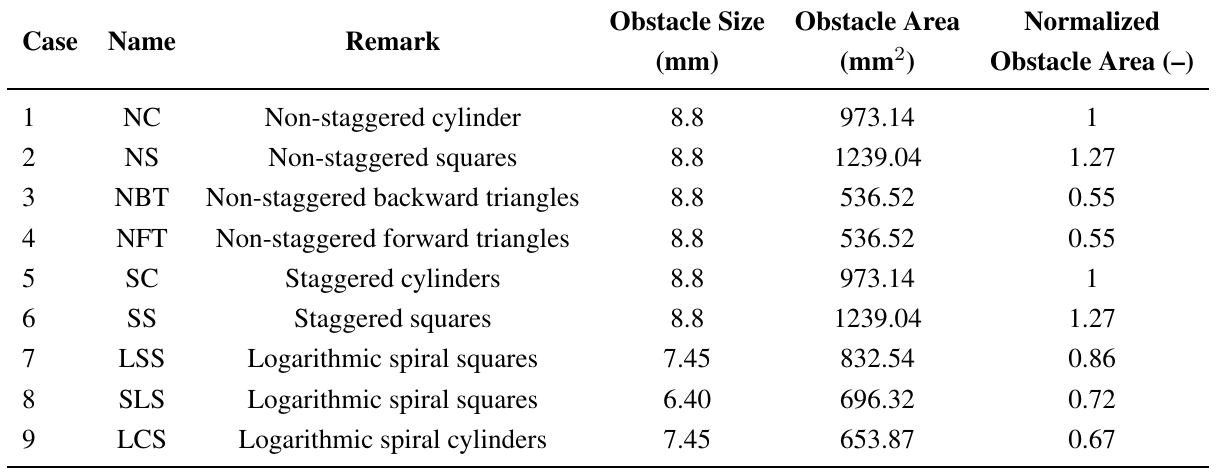
Table 1. Summary of simulated cases with details on obstacle size and total area covered by the obstacles.